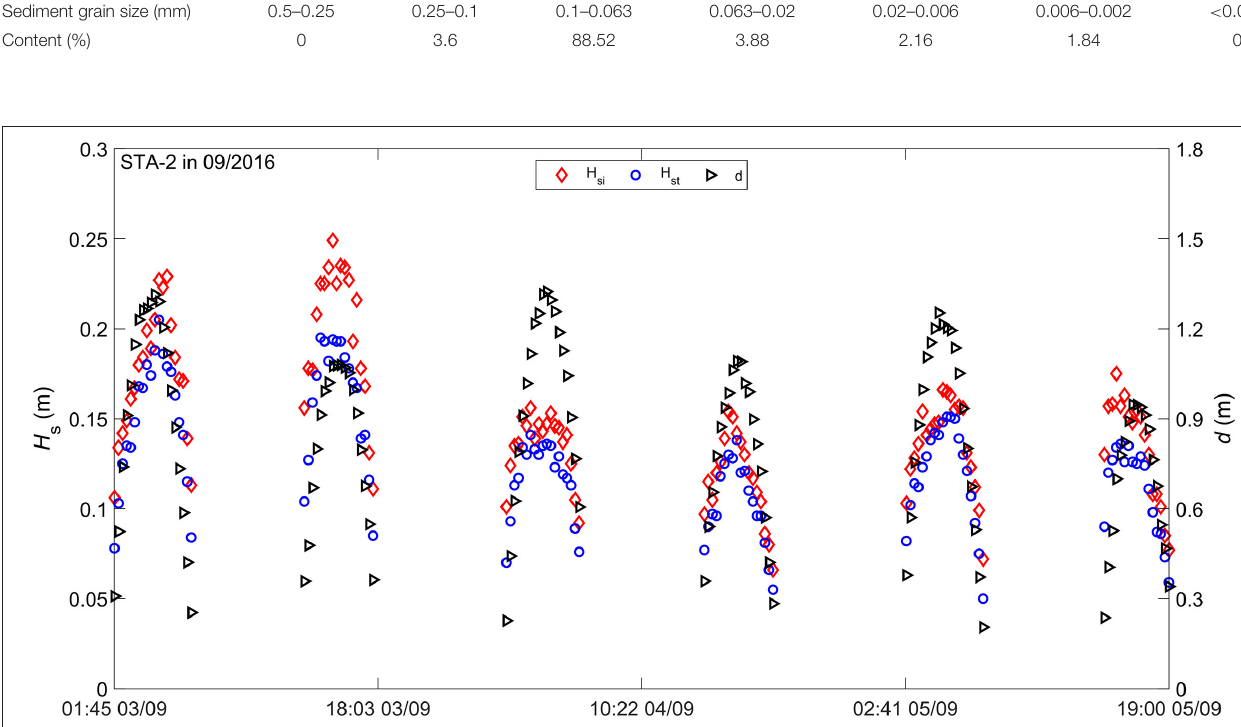
TABLE 1 | Sediment grain size at the Nha Mat coast.